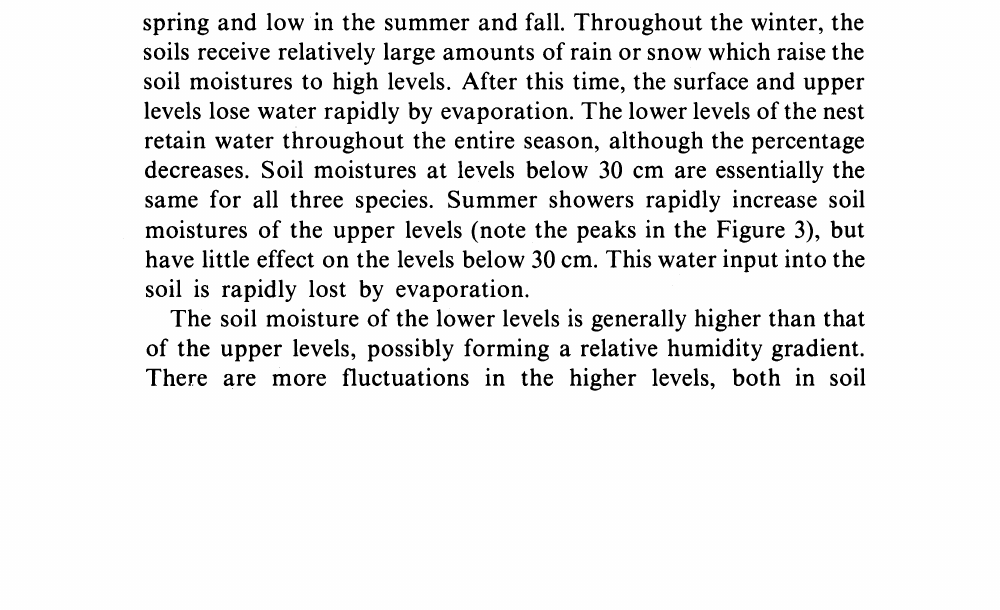
Figure 3. Seasonal changes in the nest humidities of three species of Pogonomyrmex harvester ants.